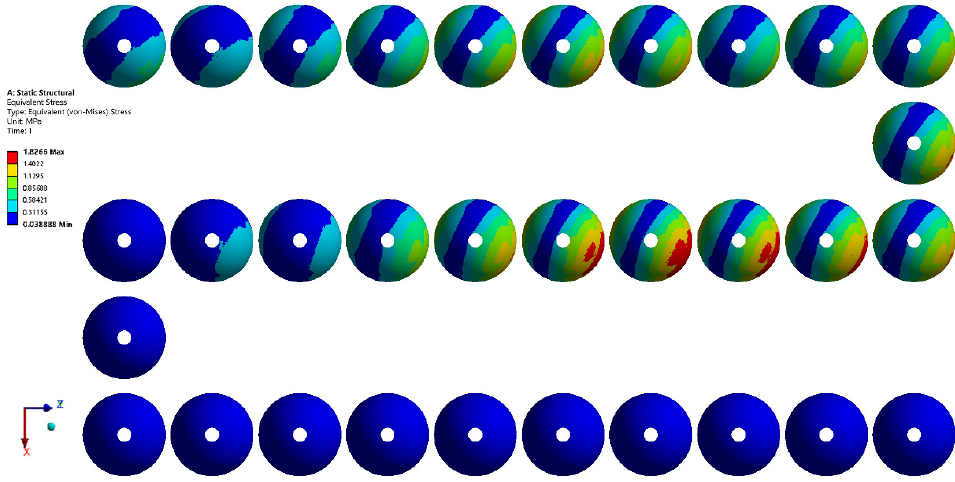
Figure 10. Stress map of the trabecular coating on the surface of the acetabular cup at 32 transients of the gait cycle.